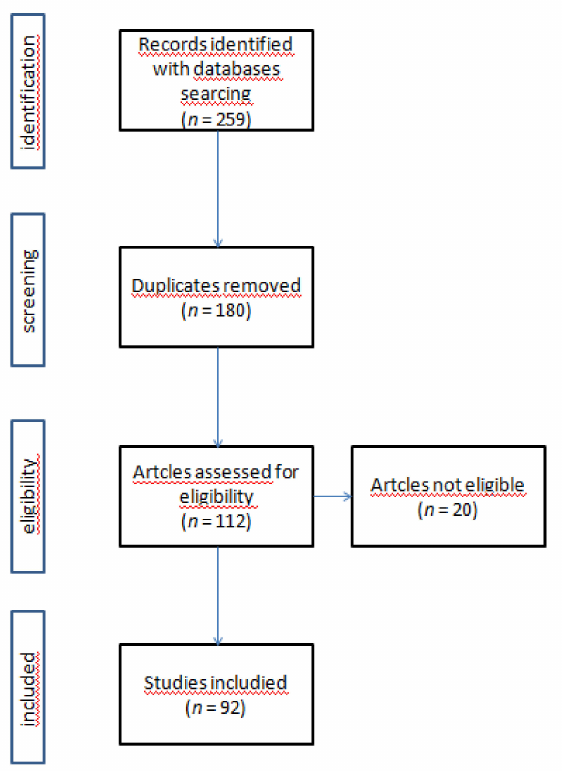
Figure 1. Research strategy with PRISMA flow